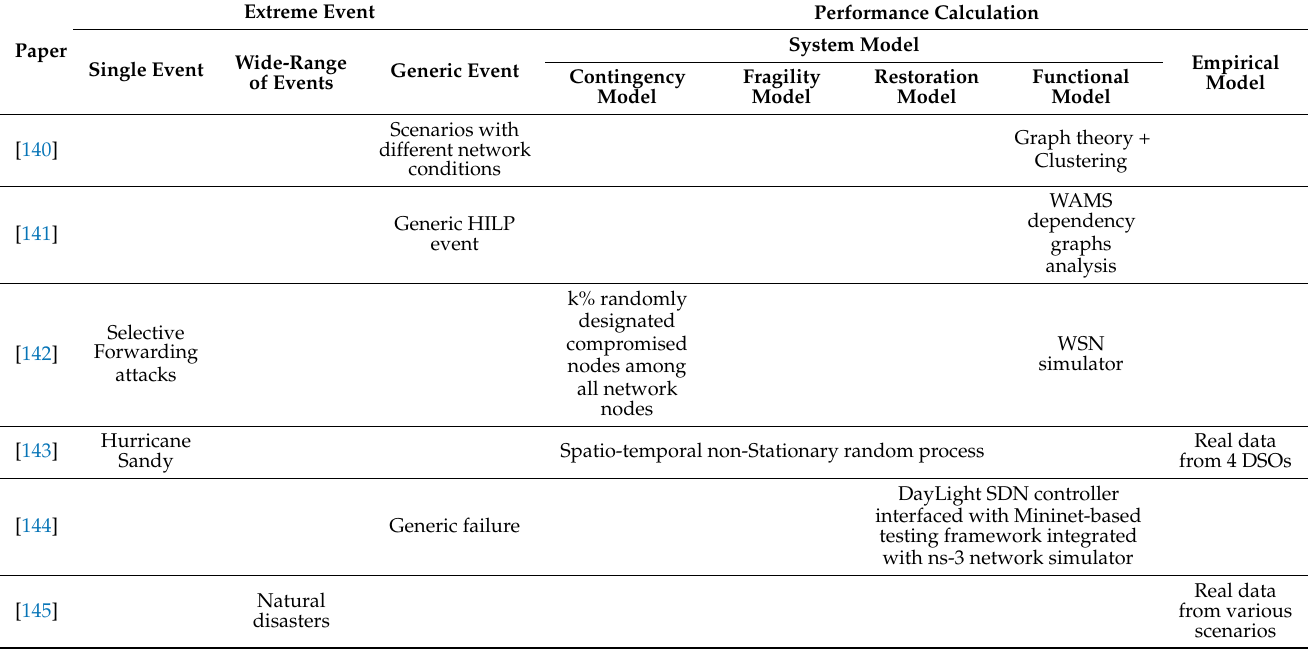
Table 4. Review of handled extreme event and performance calculation method—telecom